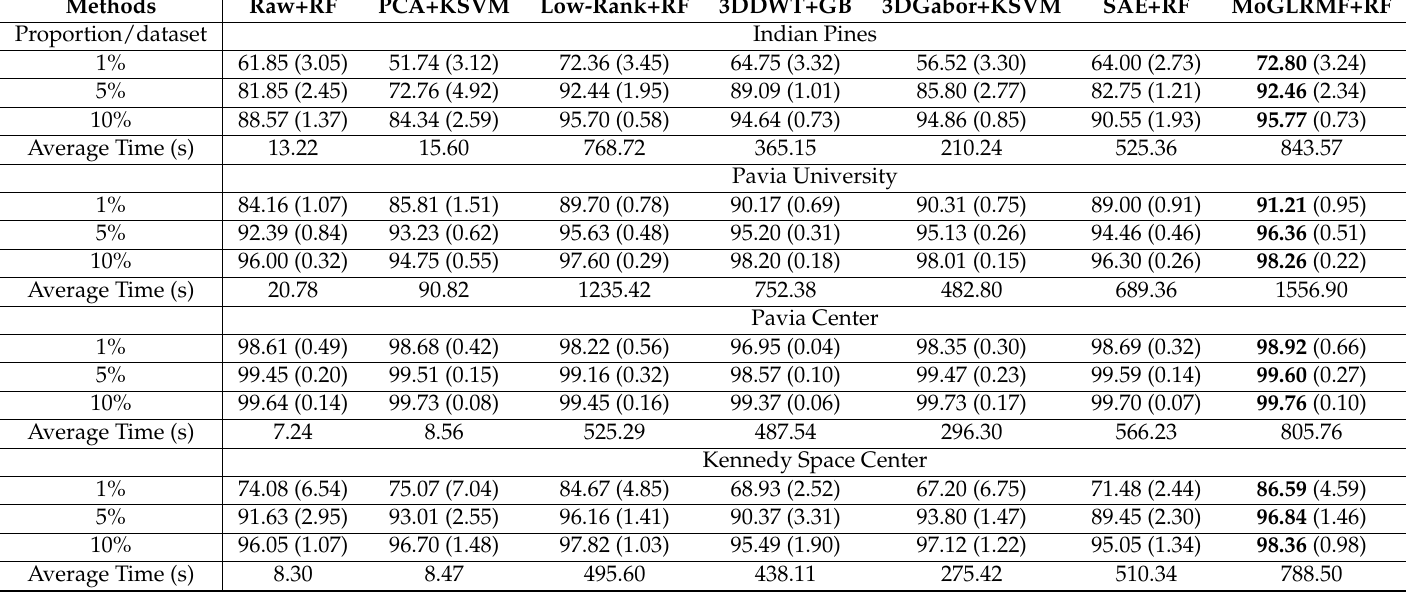
Table 5. Mean classification overall accuracy (OA), standard deviation (std) (%) and time cost on four benchmark datasets using SHIP package. The best result for each setting is highlighted in